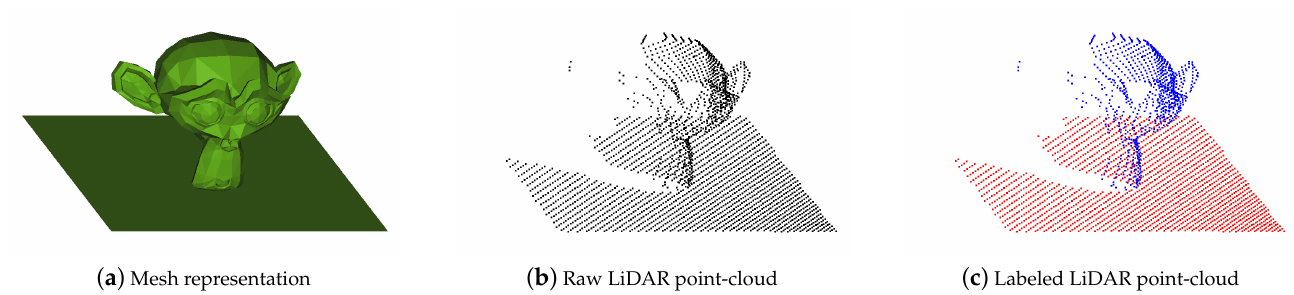
Figure 1. In ( a ) the mesh representation of a certain object ( Suzanne ) is shown. ( b ) comprises the virtually measured point-cloud, while in ( c ) the point-cloud is labeled for classification and segmentation